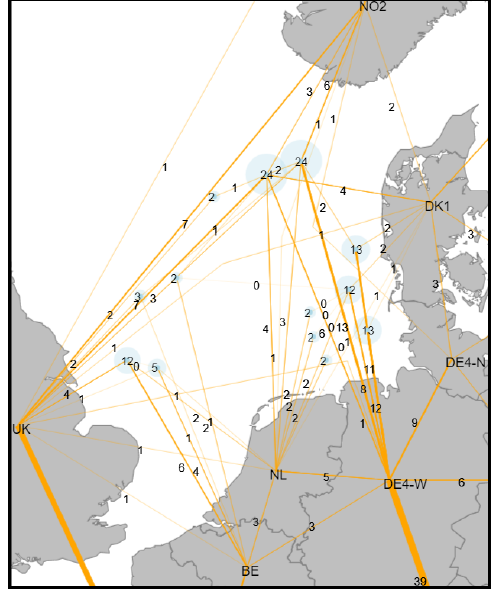
Figure 13. Transmission map of the North Sea region in 2045 in the scenario Electricity, Heat and Transport . The areas hub-connected wind farms would occupy are shown in the light blue circles, and the total sizes are shown in the middle of them. The small dark blue circle shows the locations of the invested hubs. Transmission lines (interconnectors) are colored in orange. All numbers are in GW and have been